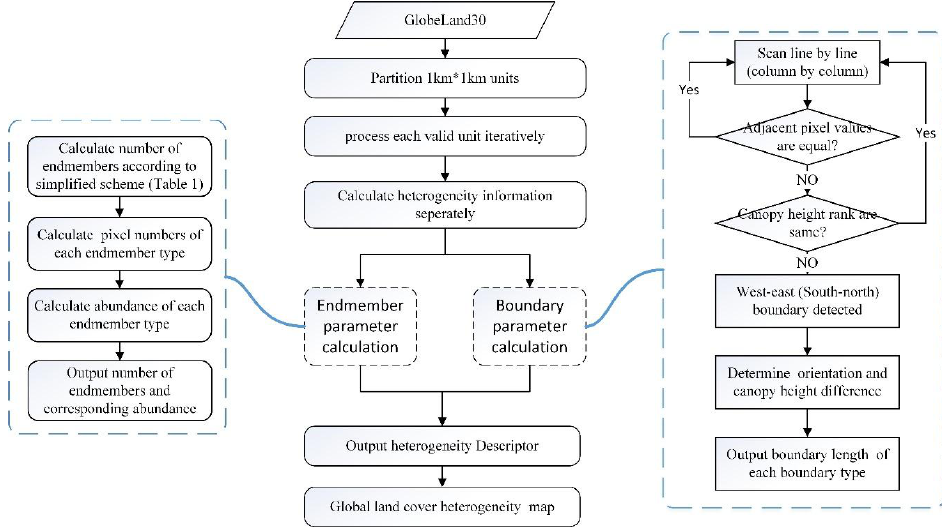
Figure 3. Flow chart describing the extraction procedures of land cover heterogeneity.